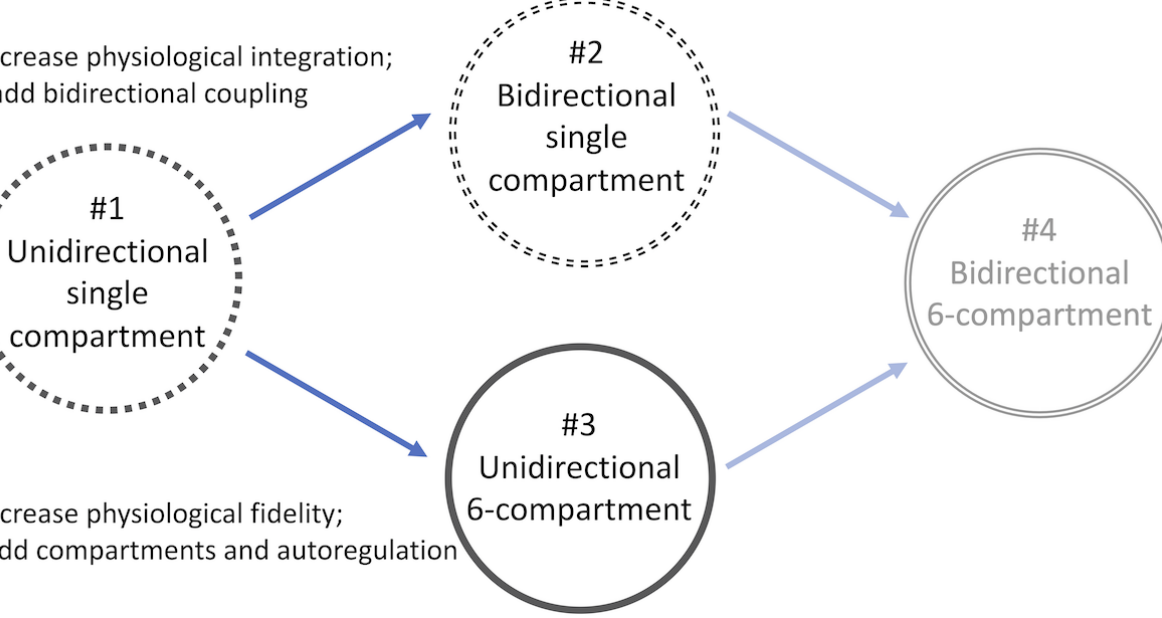
Figure 1. Conceptual overview of the relation among 4 models. The single-compartment model forced by prescribed hemodynamic time series (model #1) is the baseline model for comparison. Model #2 bidirectionally integrates the lower arterial network with the single-component intracranial model. In contrast, model #3 uses a more complex 6-compartment intracranial model with prescribed hemodynamic forcing. Model #4 represents of a multicompartment intracranial model fully integrated with the systemic